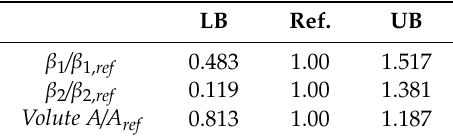
Table 1. Ranges of design variables.